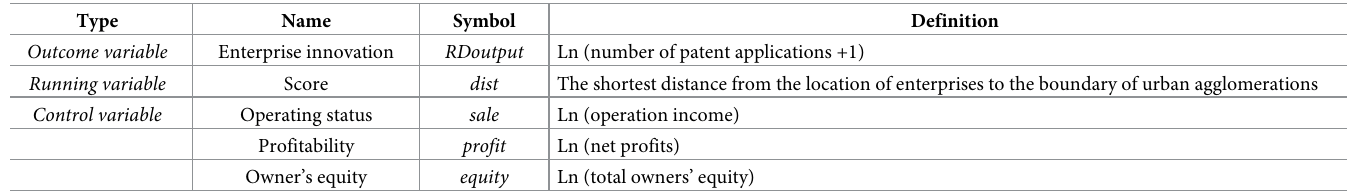
Table 1. Variable